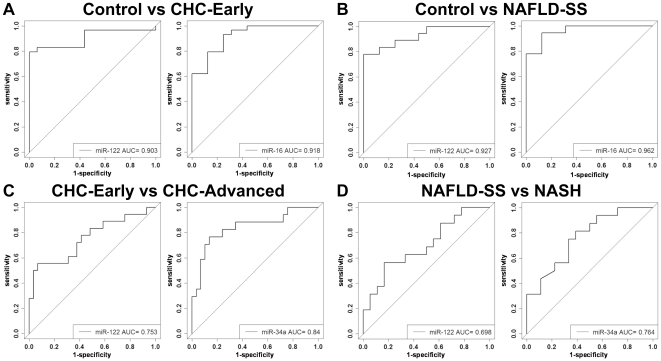
Receiver operating characteristic (ROC) analysis of expression of miRNAs in CHC and NAFLD patients.ROC curves with corresponding area under the ROC curve (AUC) for (A): mir-122 and miR-16 from CHC-early versus controls; (B) mir-122 and miR-16 from NAFLD-SS (NAS 1-4) versus controls; (C) miR-122 and miR-34a from CHC-early versus CHC-advanced; (D) miR-122 and miR-34a from NAFLD-SS(NAS 1-4) versus NASH (NAS 5–7).